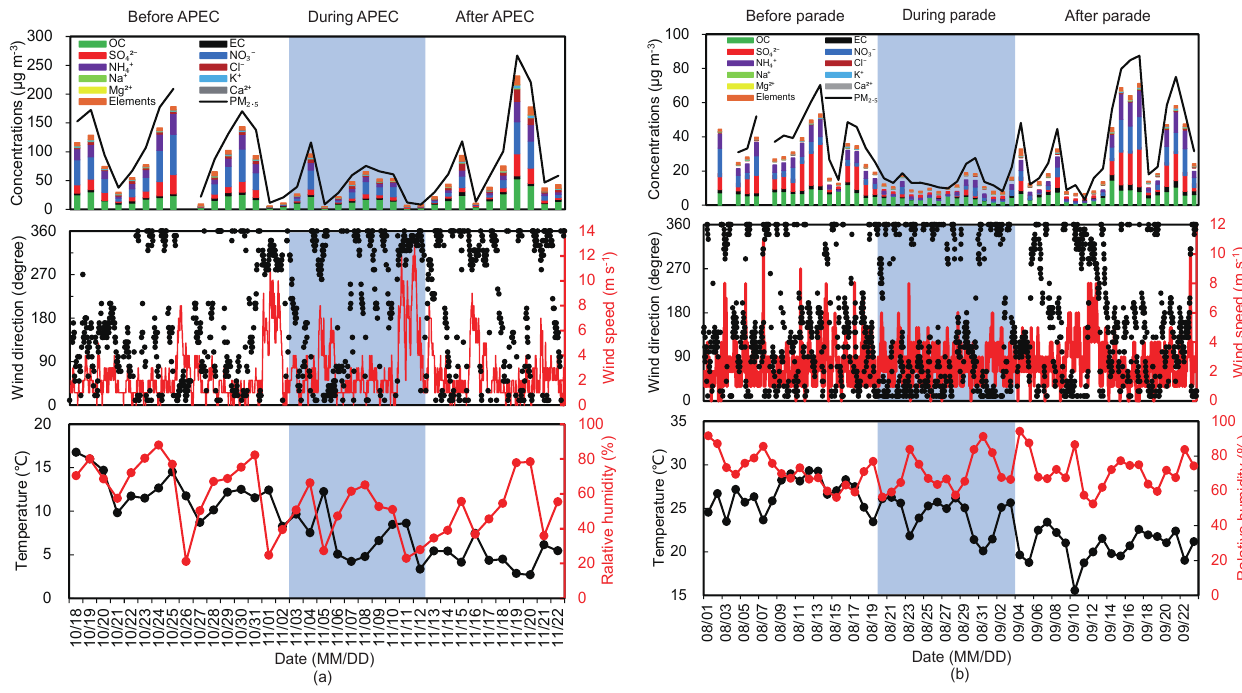
Figure 1. Time series of atmospheric particulate matter of aerodynamic diameter ≤ 2 . 5µm (PM 2 . 5 ) and the concentrations of its components, wind direction (WD), wind speed (WS), temperature ( T ), and relative humidity (RH) before, during, and after (a) APEC 2014 and (b) Victory Parade 2015. The blue-shaded areas highlight the pollution control periods of APEC 2014 (3 November to 12 November 2014) and Victory